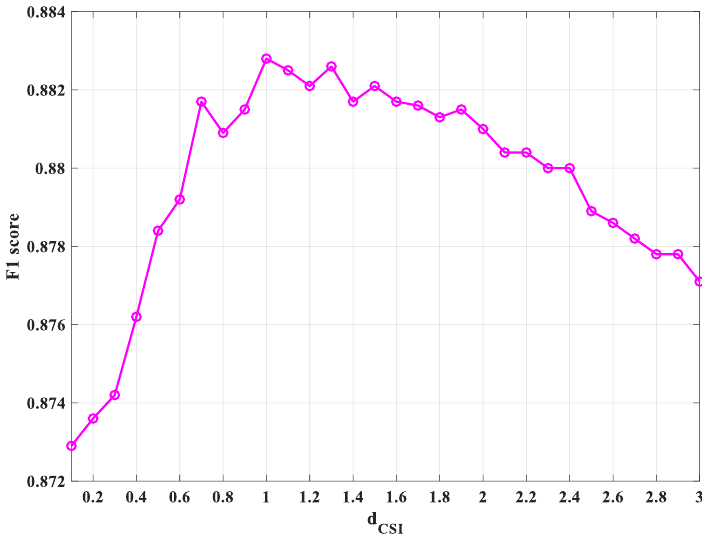
Figure 9. Performance of RF models (in terms of F1 score) for various d CSI